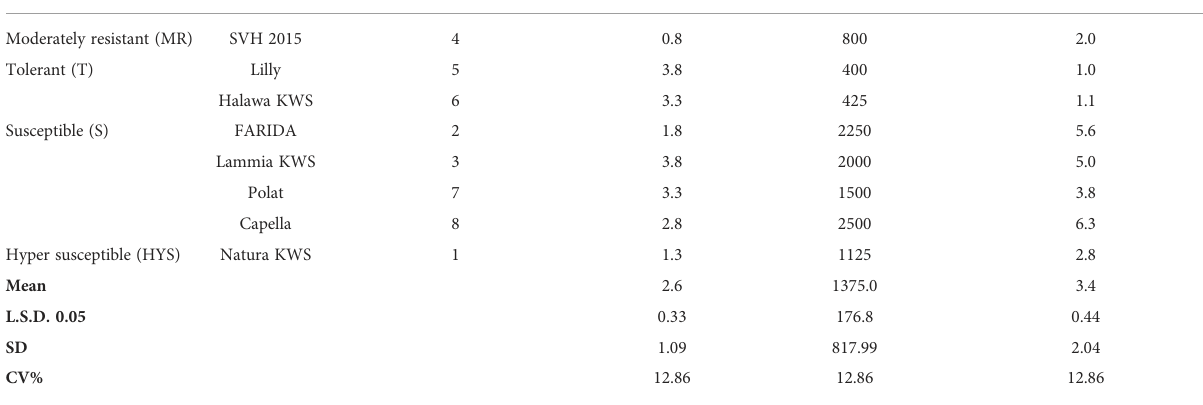
TABLE 4 Host suitability after adapted quantitative scheme of Canto-Saenz (AQSCS) for sugar beet genotypes (Beta vulgaris saccharifera) tested for root-knot nematode, Meloidogyne incognita . Genotypes response Sugar beet varieties